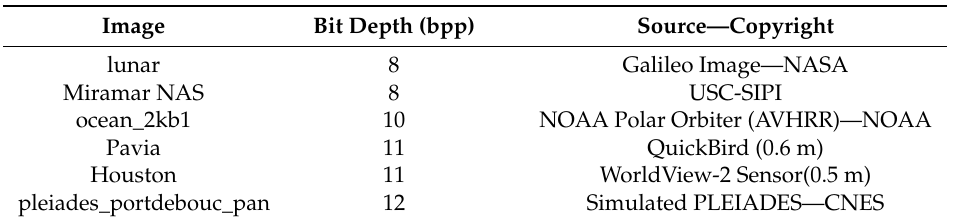
Table 2. List of the test image